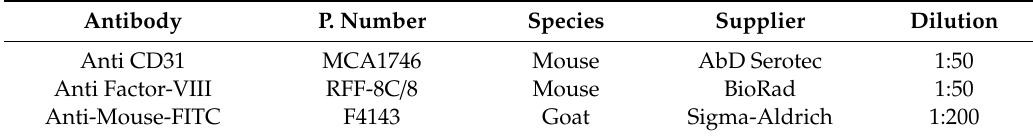
Table 2. Antibodies Used for the Immunofluorescence Analysis on the Spheroids. Antibody P.